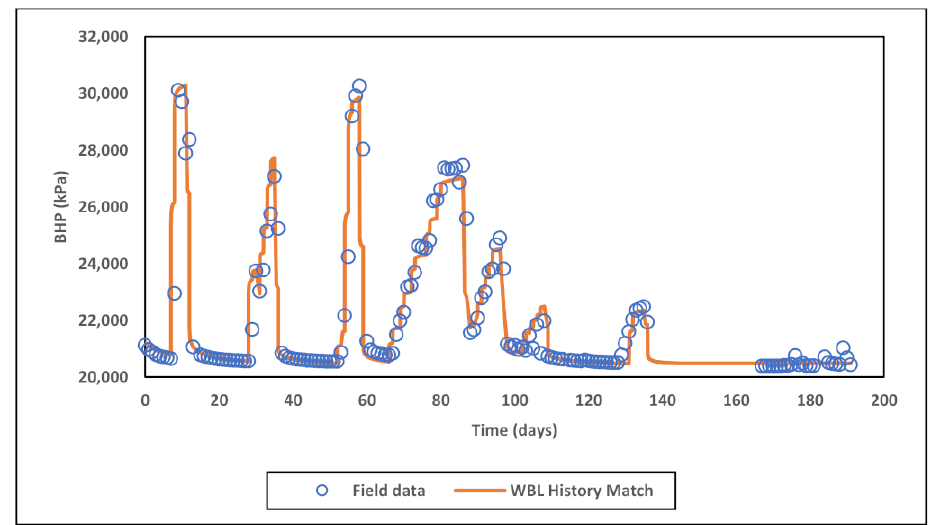
Figure 10. History match of water injection baseline BHP.